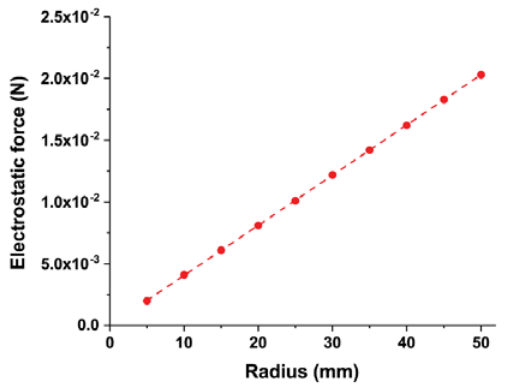
Figure 8. Electrostatic force changes due to variation in the radius of the X-shaped actuator